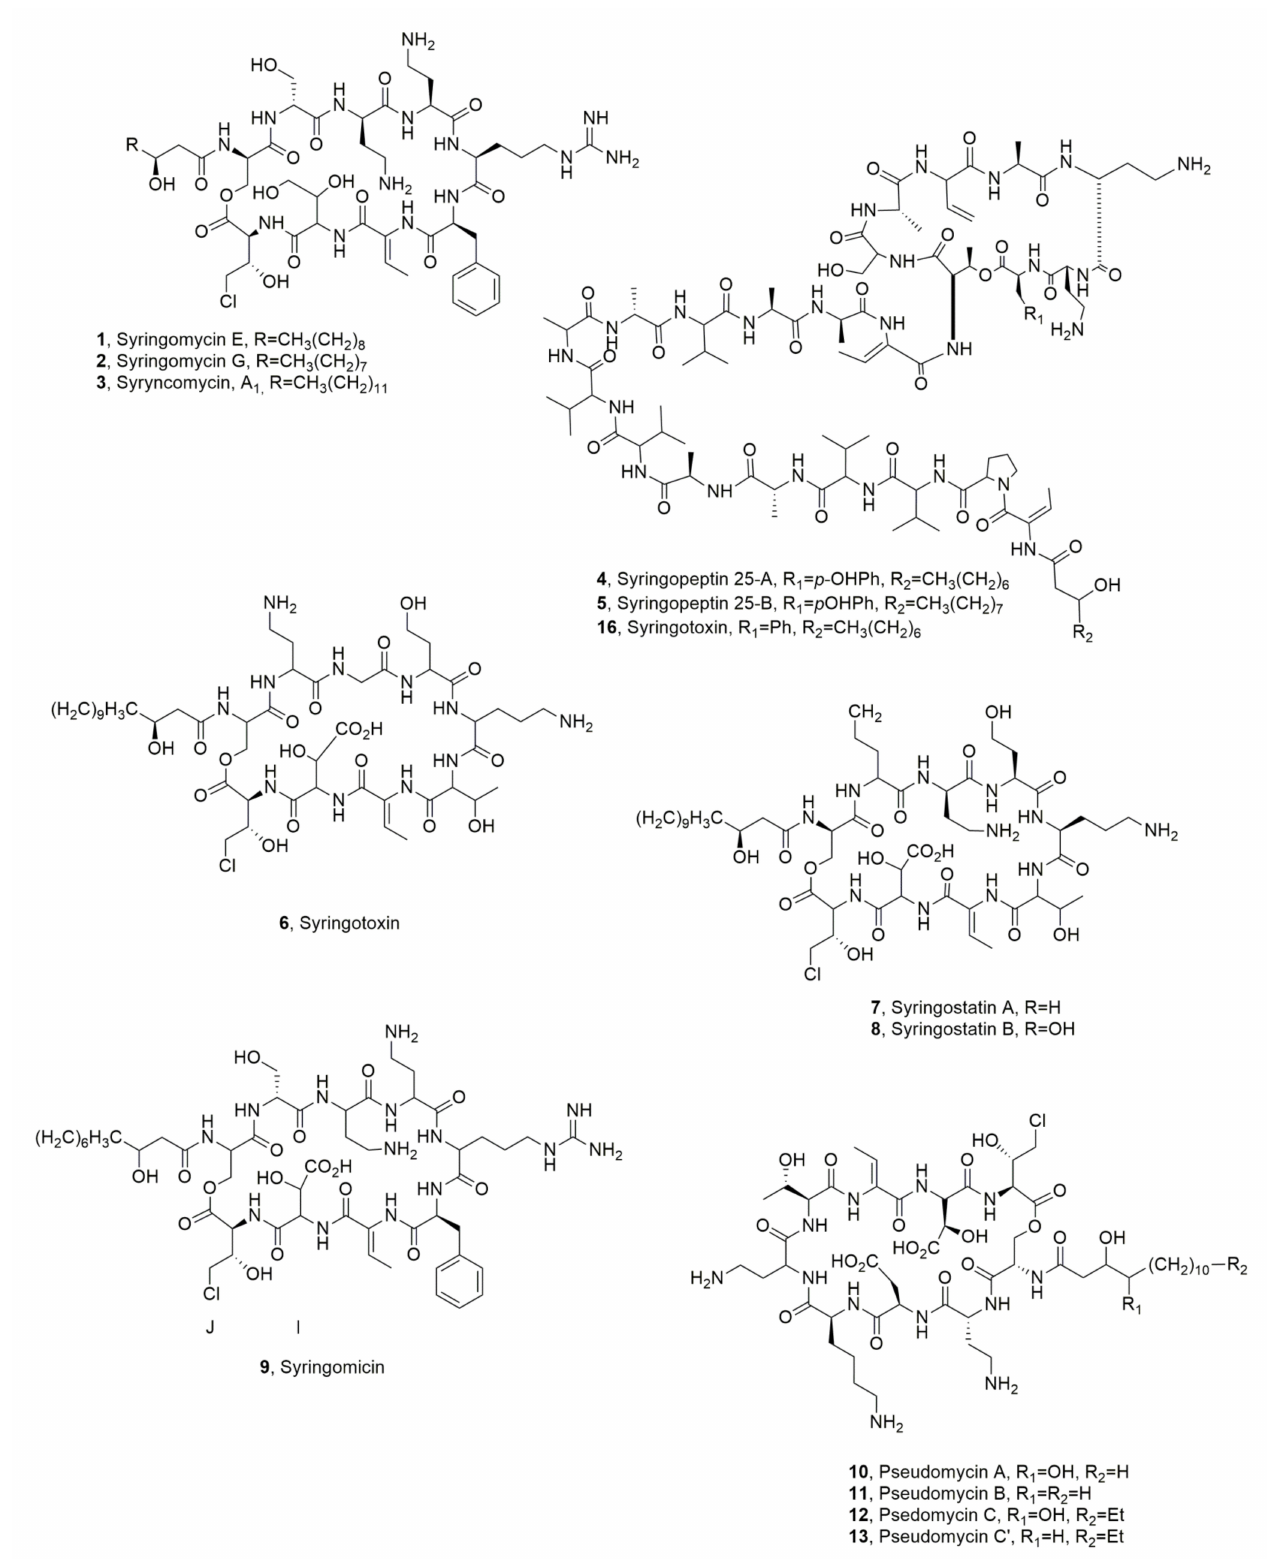
Figure 3. Lipodepsipeptides produced by different strains of Pseudomonas syringae pv. syringae ( 1 – 13 and 16